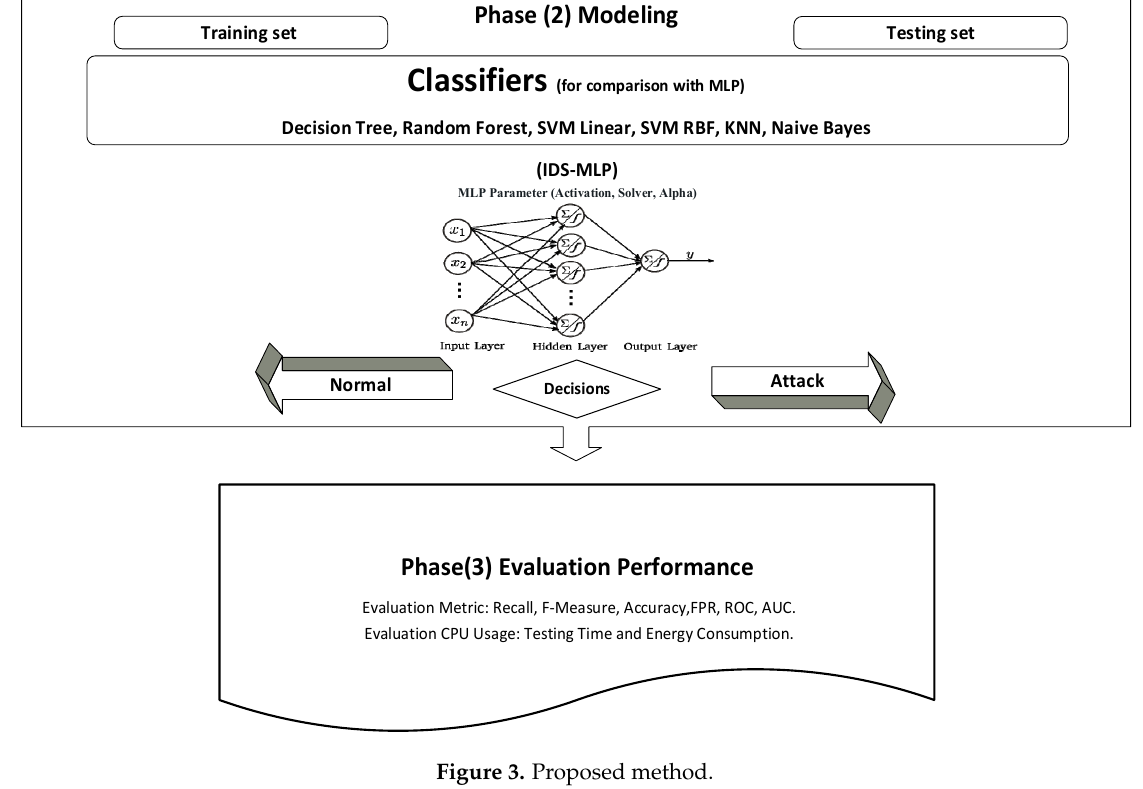
Figure 3. Proposed method.